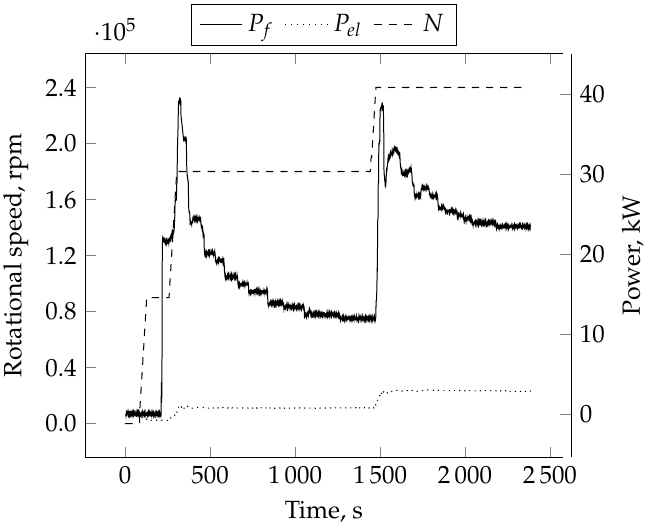
Figure 3. Cold start maneuver up to full-load, steady state. T rec = 450 K. P el = electrical power, P f = fuel power, and N = rotational